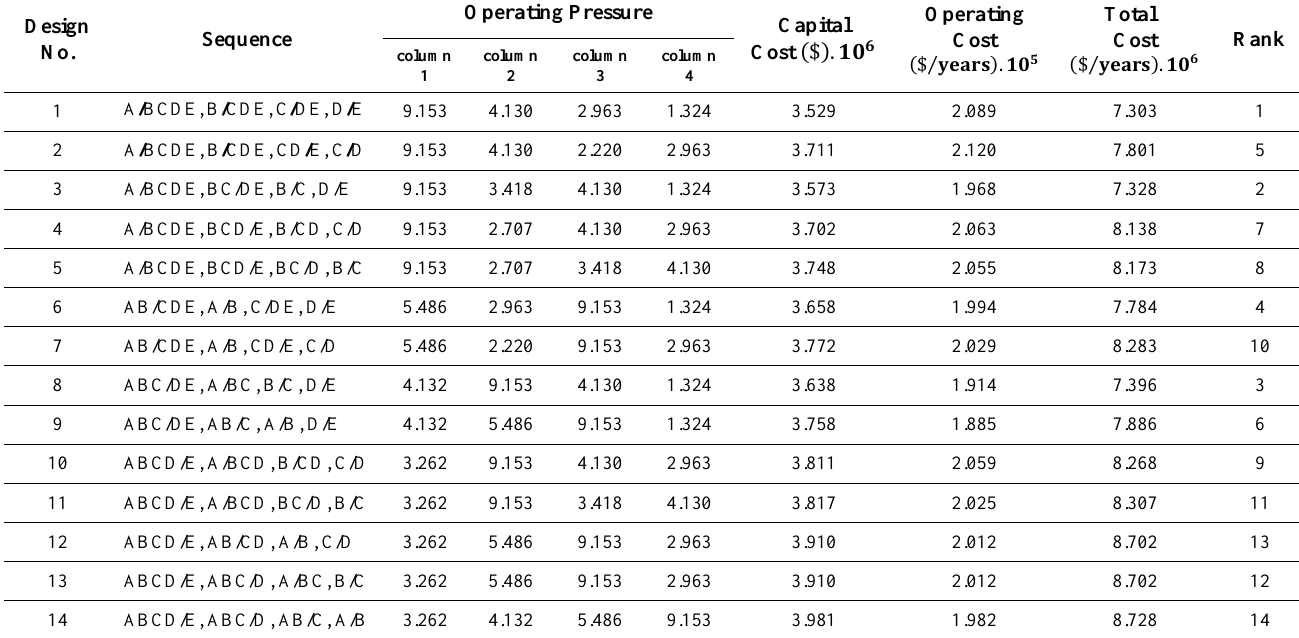
Table 6. Designing all of the feasible column sequences at 35 ℃ and have been ranked based on Total Annual Cost (TAC) as an object function.